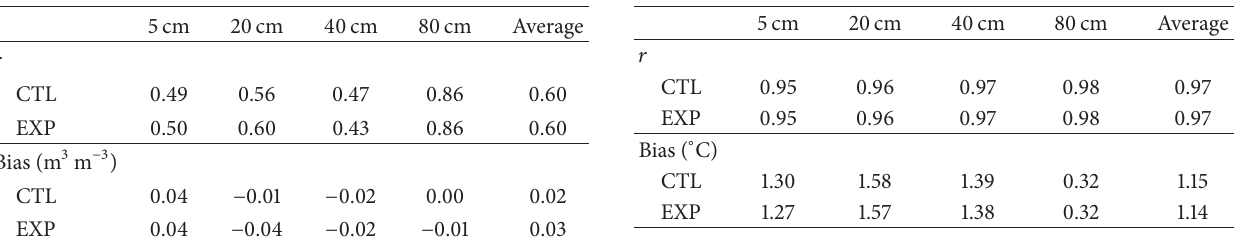
Table 6: Same as Table 5 but at GS